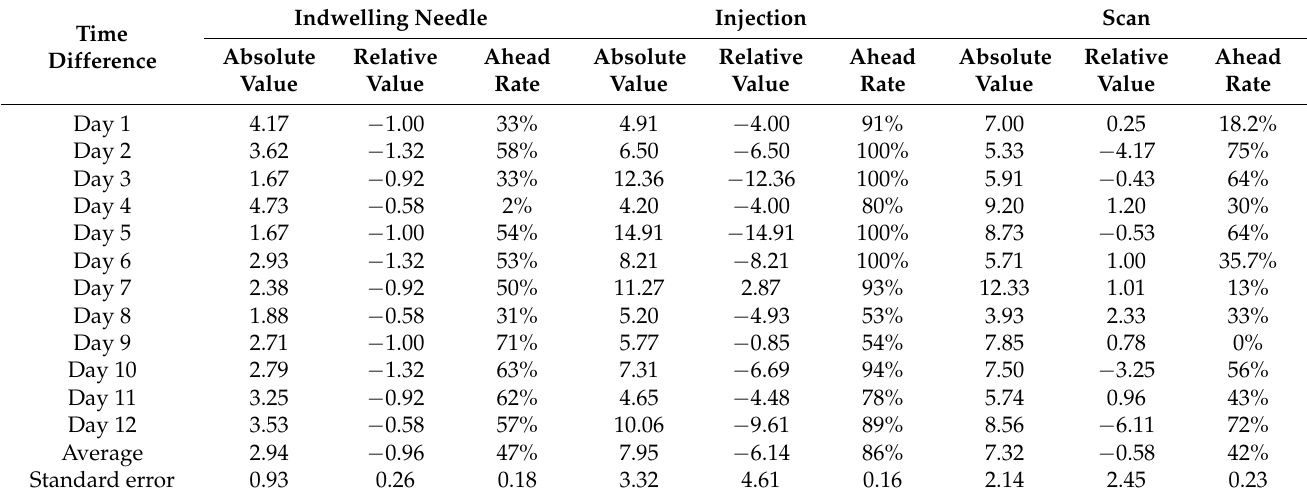
Table 3. Time difference between the two groups and ahead rate (unit: min).